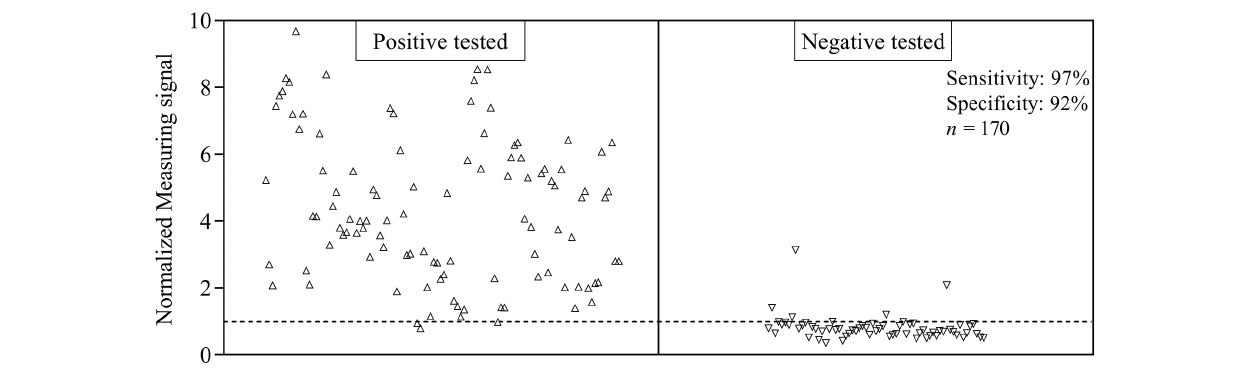
Frontiers in Microbiology |